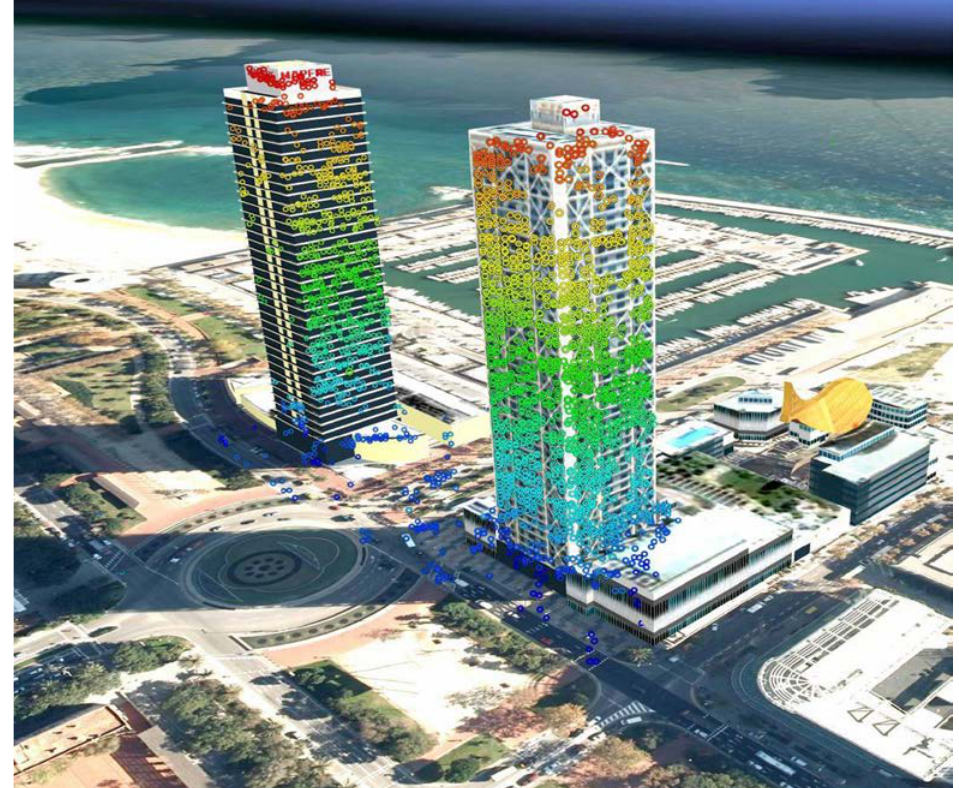
Figure 1. PSI result using TerraSAR-X data (Crosetto et al., 2010). One may appreciate the high density of measured points, which in this case are colour-coded according to the estimated height of the points with respect to a digital terrain